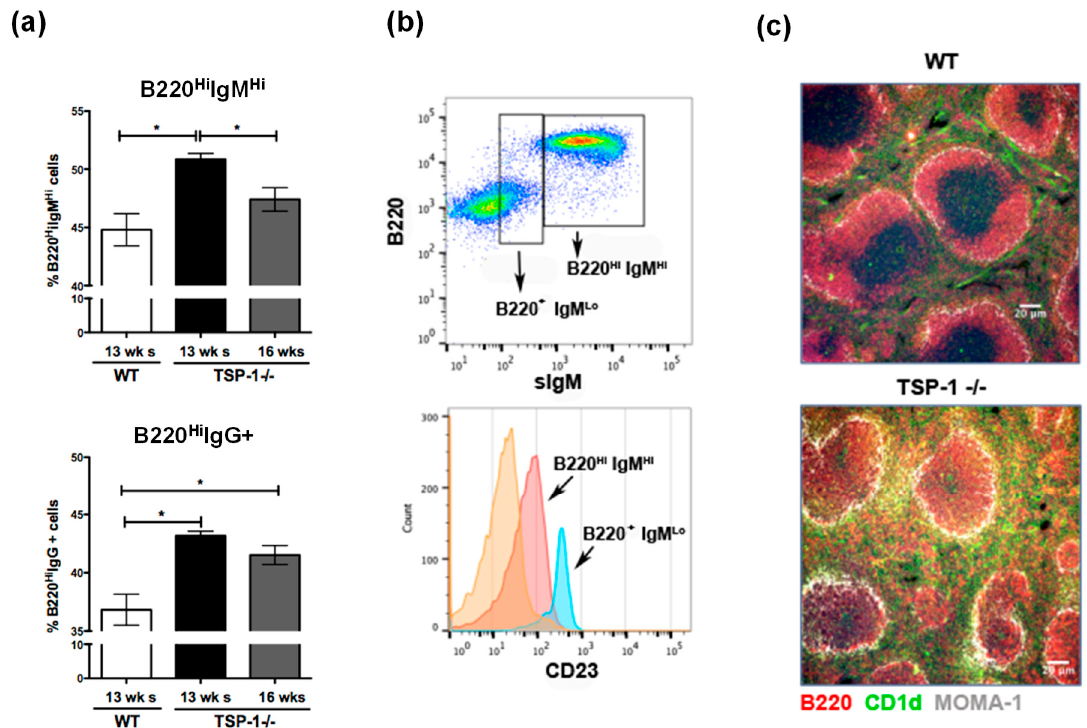
Figure 1. Frequency of marginal zone B (MZB) cells is increased in thrombospondin-1 deficient (TSP1 − / − ) spleens. ( a ) Frequency of B220 Hi cells in the spleens of wild-type (WT) and TSP1 − / − mice of indicated ages as detected that had high levels of immunoglobulin M (IgM Hi ) or IgG + by flow cytometric analysis. ( b ) Levels of cluster of differentiation 23 (CD23) expression in splenic B220 + subsets. ( c ) Intrasplenic structural differences between WT and TSP1 − / − mice in the distribution of MZB cells (yellow) identified by immunostaining for B220 (red) and CD1d (green). Metallophilic macrophages are identified by anti-metallophilic macrophages antibody (MOMA-1; grey white) staining around follicles (100×; scale bar, 20 µm; * p < 0.05).